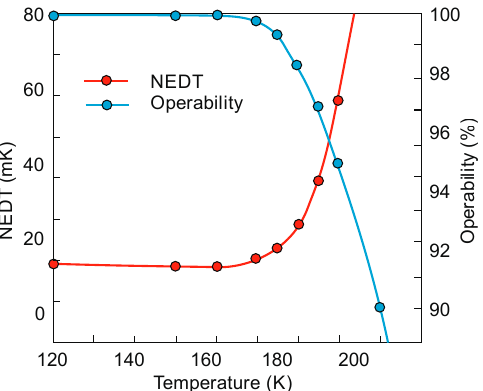
Figure 72. “Kinglet” NEDT and pixel operability temperature dependence for f / 3.2 optics (after [206]).